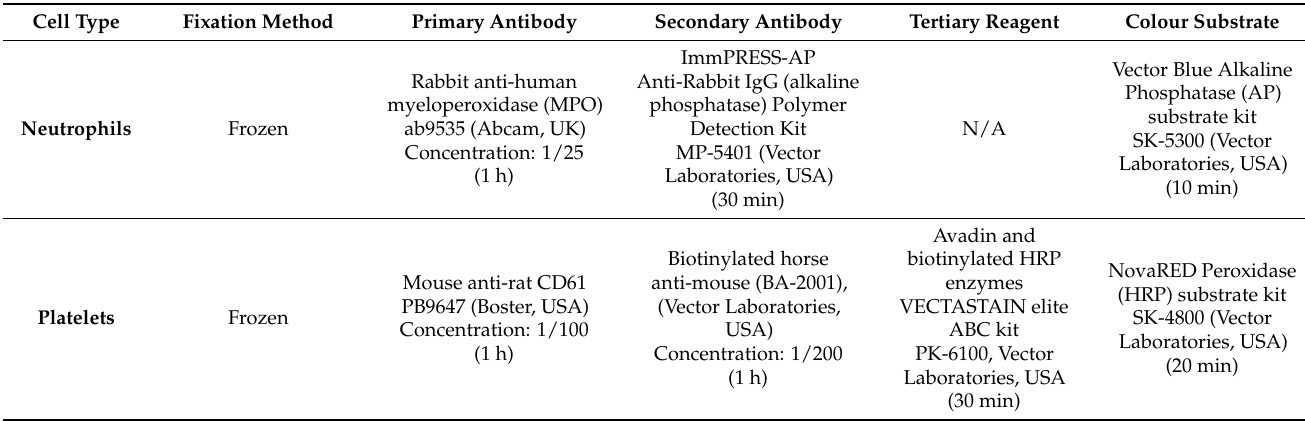
Figure 2. Neutrophil immunohistochemistry in rat lung and liver tissues. For protocol optimisation, sections were immunostained with primary antibody ( A ) and without primary antibody ( B ), to detect any unspecific binding of detection reagents. Representative images of neutrophil immunohistochemistry (anti-MPO) in FFPE rat lung tissue ( C , D ) and FFPE rat liver tissue ( E , F ) are also shown. Asterisks denote blood vessels; black dotted lines denote airway wall. Scale bar = 100 µ m in images ( A , B , D , E ) (×20 objective), 50 μ m in image ( F ) (×40 objective) and 20 μ m in image ( C ) (×63 objective). Table 6. Staining strategy for co-localisation